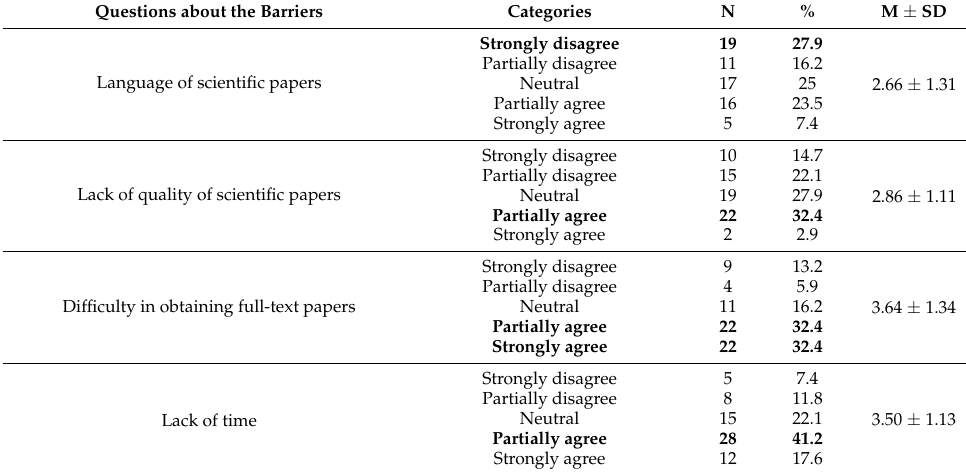
Table 5. Self-reported characteristics related to